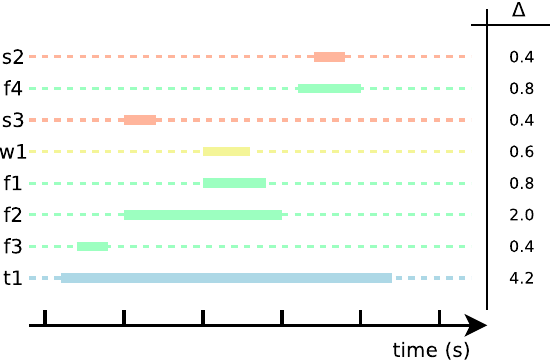
Figure 2. An example of a time diagram of the activities triggered by t 1. The color reminds the kind of activity: scheduled, function, dataset, or external. The right column indicates the activity duration in